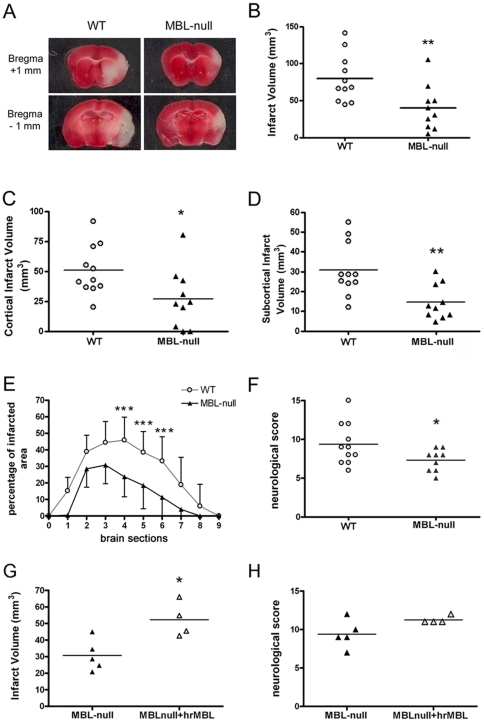
MBL-null mice develop smaller infarct volumes than wild-type mice.A) Representative images of infarcted brain tissue in wild-type (WT) and MBL-null mice at 48 h post-ischemia. The approximate level of the brain sections is indicated in the left by the distance from Bregma. B) Infarct volume was lesser in the MBL-null group (n = 11) than in WT (n = 10). C) Cortical and D) subcortical infarct volumes were smaller in MBL-null than in WT mice. E) The percentage of tissue with infarction per brain section (1 mm-thick) is shown for consecutive sections, starting (left) from the frontal part of the brain. The proportion of infarcted tissue is smaller in MBL-null than in WT mice. Values are expressed as the mean±SD. Two-way ANOVA by genotype and brain section showed significant differences due to genotype (p<0.001, F(9,40) = 18.74). Post-hoc Bonferroni test showed significant differences in the indicated brain sections. F) The neurological score was better (lower) in MBL-null mice than in WT. (G–H) MBL-null mice were treated with rhMBL (MBLnull+rhMBL) (n = 4) or vehicle (MBLnull) (n = 5). G) MBL-null mice receiving rhMBL showed larger infarct volume than non-reconstituted mice. H) A trend to worst neurological deficit (p = 0.09) was seen after reconstitution with rhMBL compared to vehicle. Symbols indicate values for individual animals. * p<0.05, ** p<0.01, *** p<0.001).